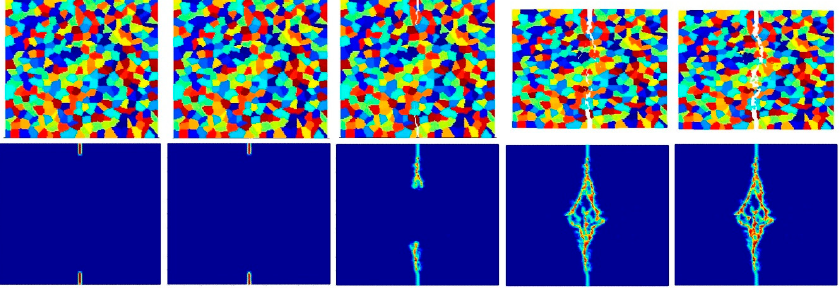
Figure 31. Fracture pattern of polycrystal when β = 2.0 with 400 grains in total. From left to right: time = 1.5 μ s, 2.0 μ s, 2.5 μ s, 3.0 μ s, and 3.5 μ s, respectively.